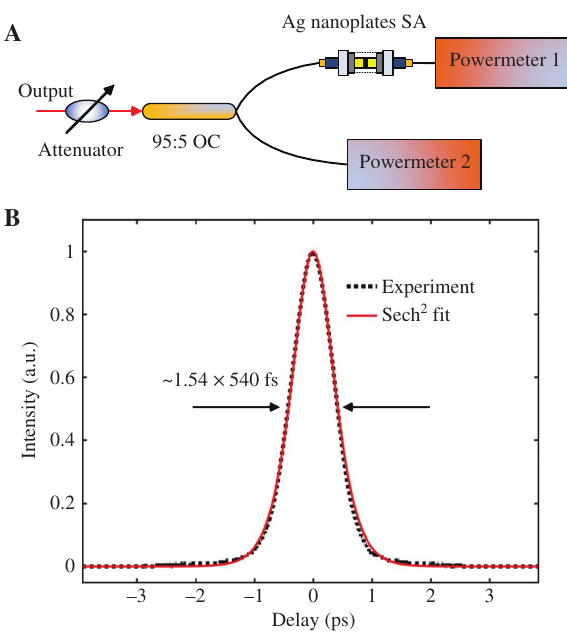
Figure 5: Experimental setup for the measurement of nonlinear saturable absorption property. (A) Schematic experimental setup for measurement of the nonlinear saturable absorption property of the Ag nanoplates SA. (B) Optical autocorrelation trace of the pulse train for the measurement.